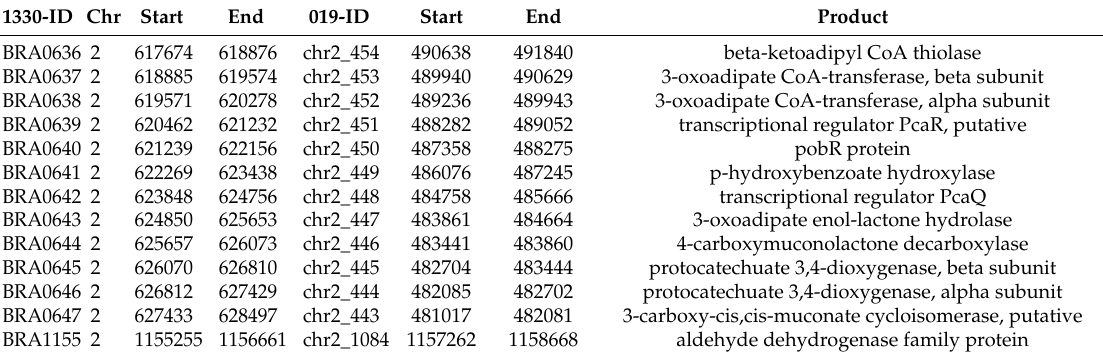
Table 3. Featured genes of